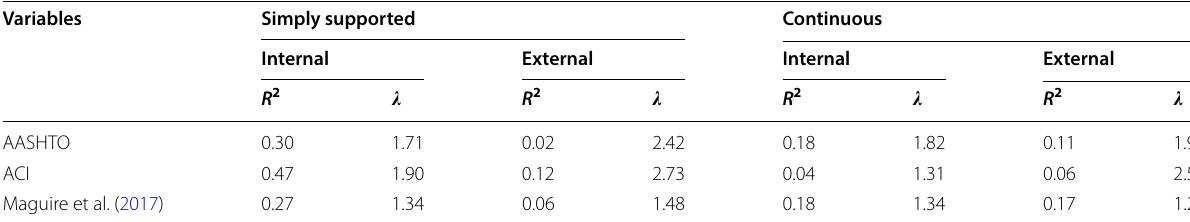
Table 5 Cross tabulated R 2 and (cid:31) model values for simply supported and Continuous tendons Variables Simply supported Continuous Internal